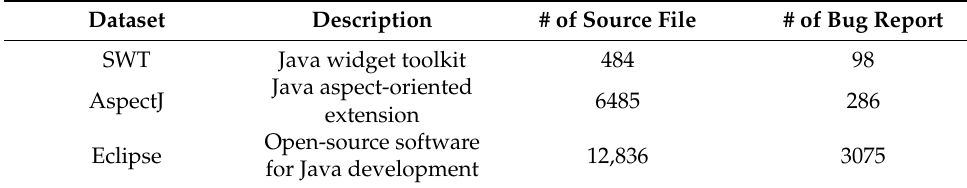
Table 1. Bug localization datasets.